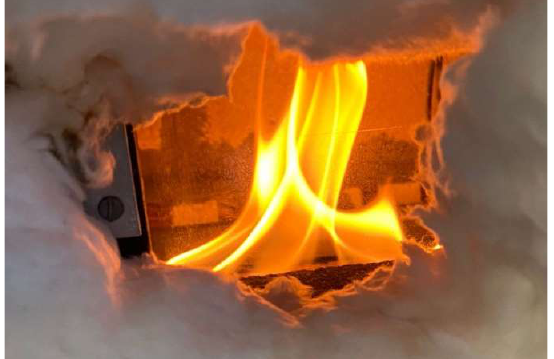
Figure 5. Moment of ignition of a batch of Pinus pinaster pellets.